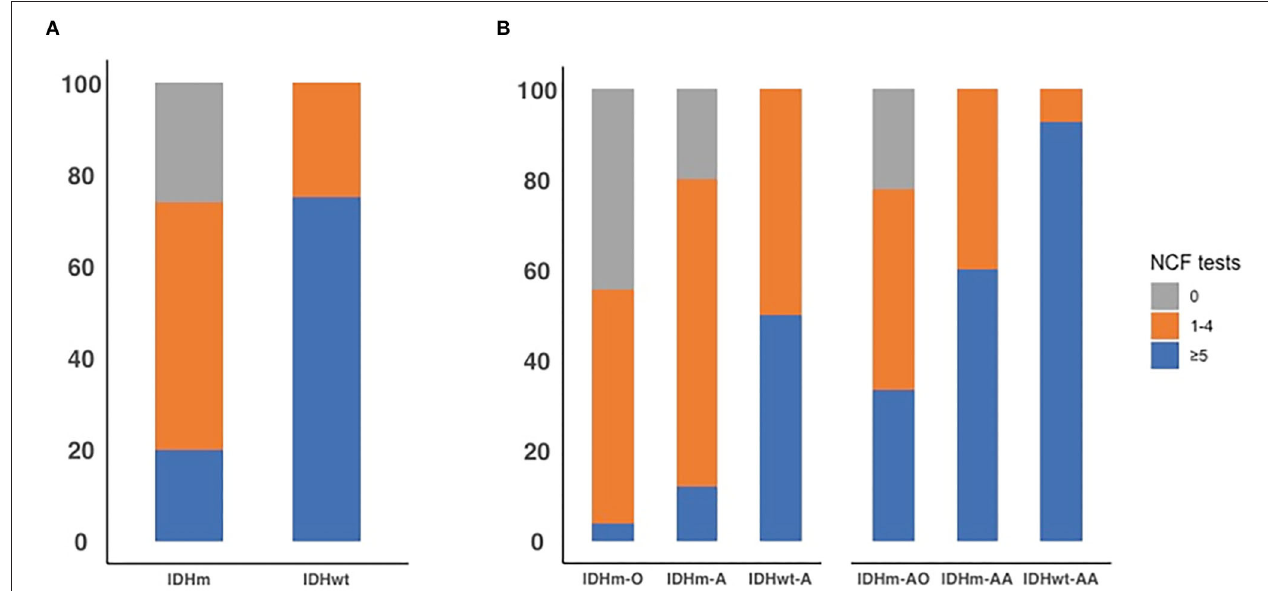
FIGURE 3 | The proportion of all patients with diffusion lower-grade glioma with neurocognitive function decline across 0 test, 1 to 4 tests, and 5 or more tests by IDH status (A) . The proportion of all patients with diffusion lower-grade glioma with neurocognitive function decline across 0 test, 1 to 4 tests, and 5 or more tests in each subgroup based on IDH status and 1p19q deletion (B) .